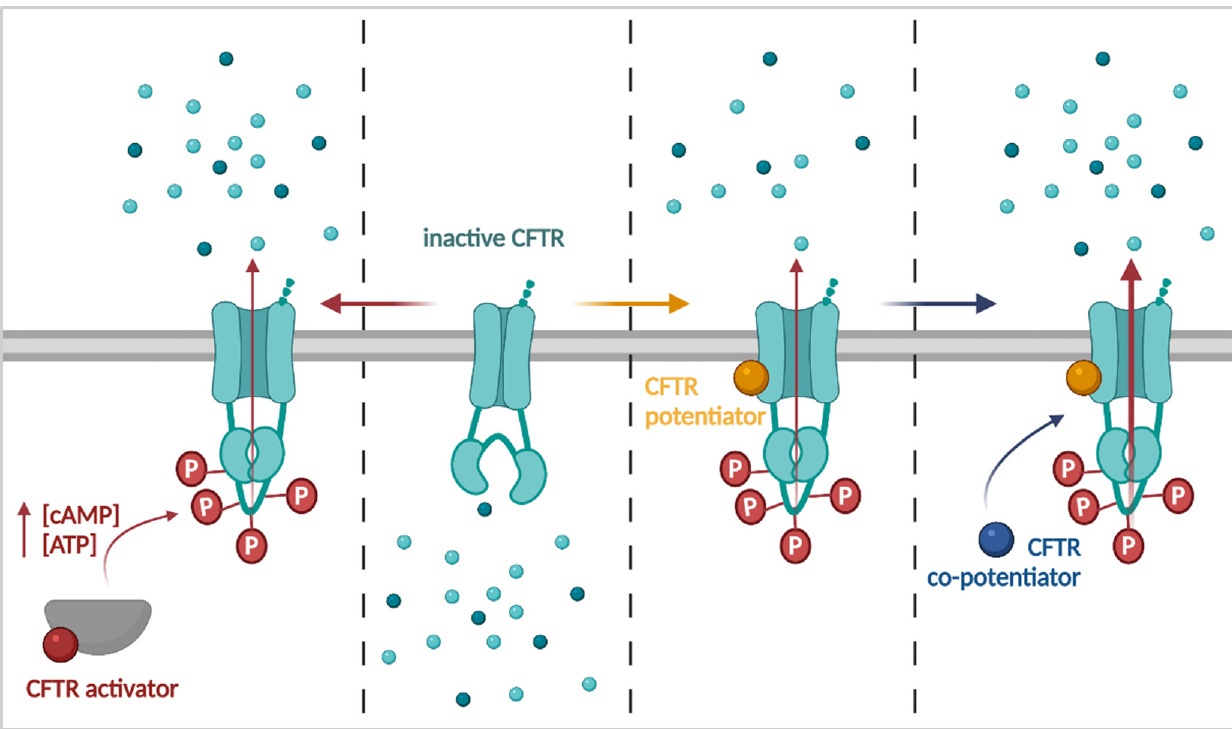
Figure 3. Strategies to improve CFTR function. Left: Activators (red) improve CFTR function by altering its normal regulation, for example by promoting phosphorylation of CFTR or via ATP analogues which lock CFTR in an open state. Right: CFTR potentiators (orange) interact directly with CFTR to promote function, in a phosphorylation-dependent, but ATP-independent manner. Co-potentiators (blue) also interact with CFTR, to further stimulate function but only in the presence of CFTR